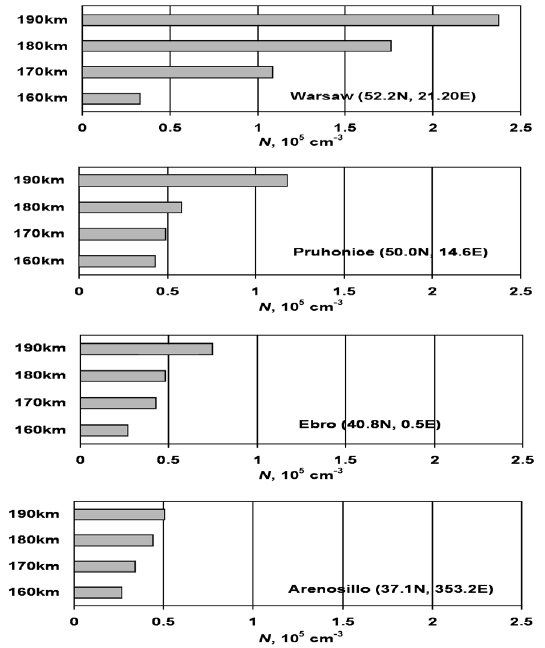
Fig. 12.2. The magnitude of the electron density decrease at the F 1-region heights (the difference between pre- storm quiet days and the storm main phase at 11:00-13:00 UT) for the storm of February 1998 for Warsaw, Pruhonice, Ebro and